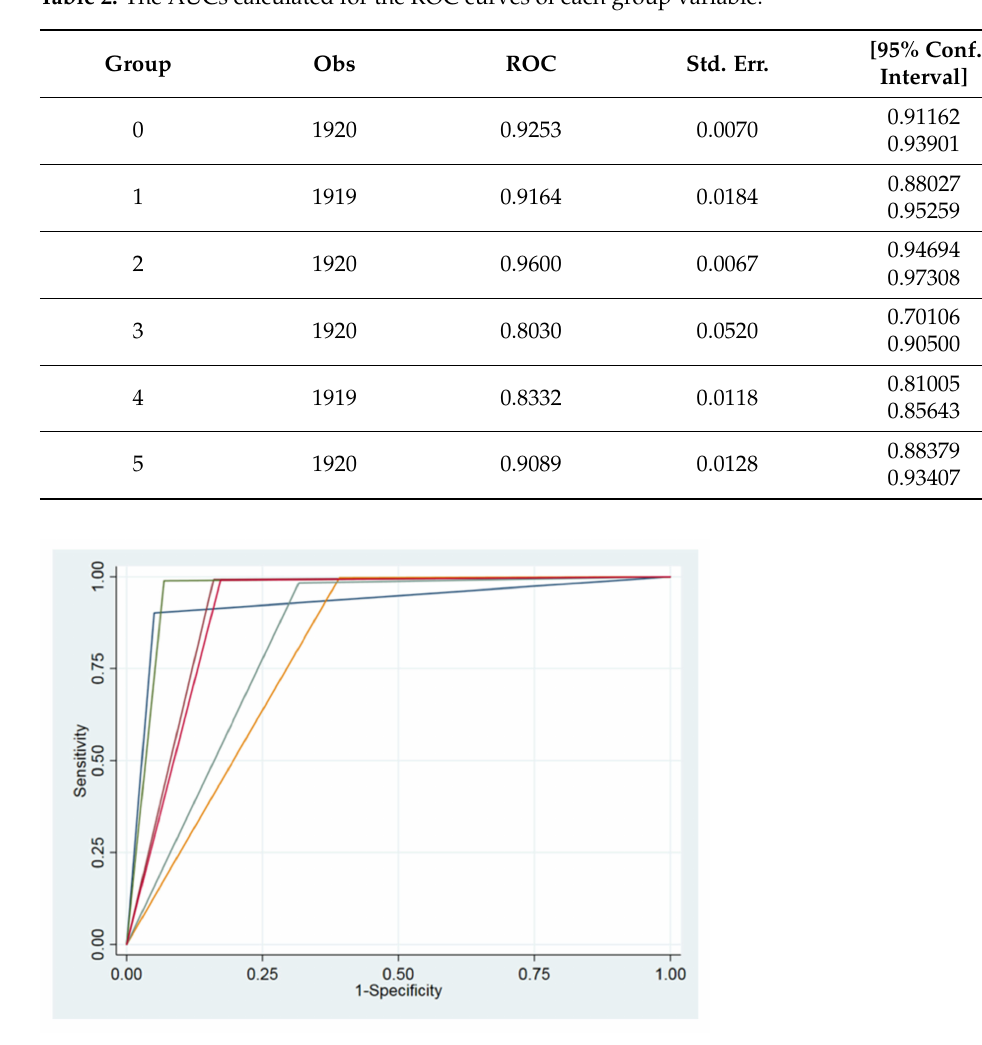
Figure 7. The area under the ROC curve (AUC). Table 2. The AUCs calculated for the ROC curves of each group variable.